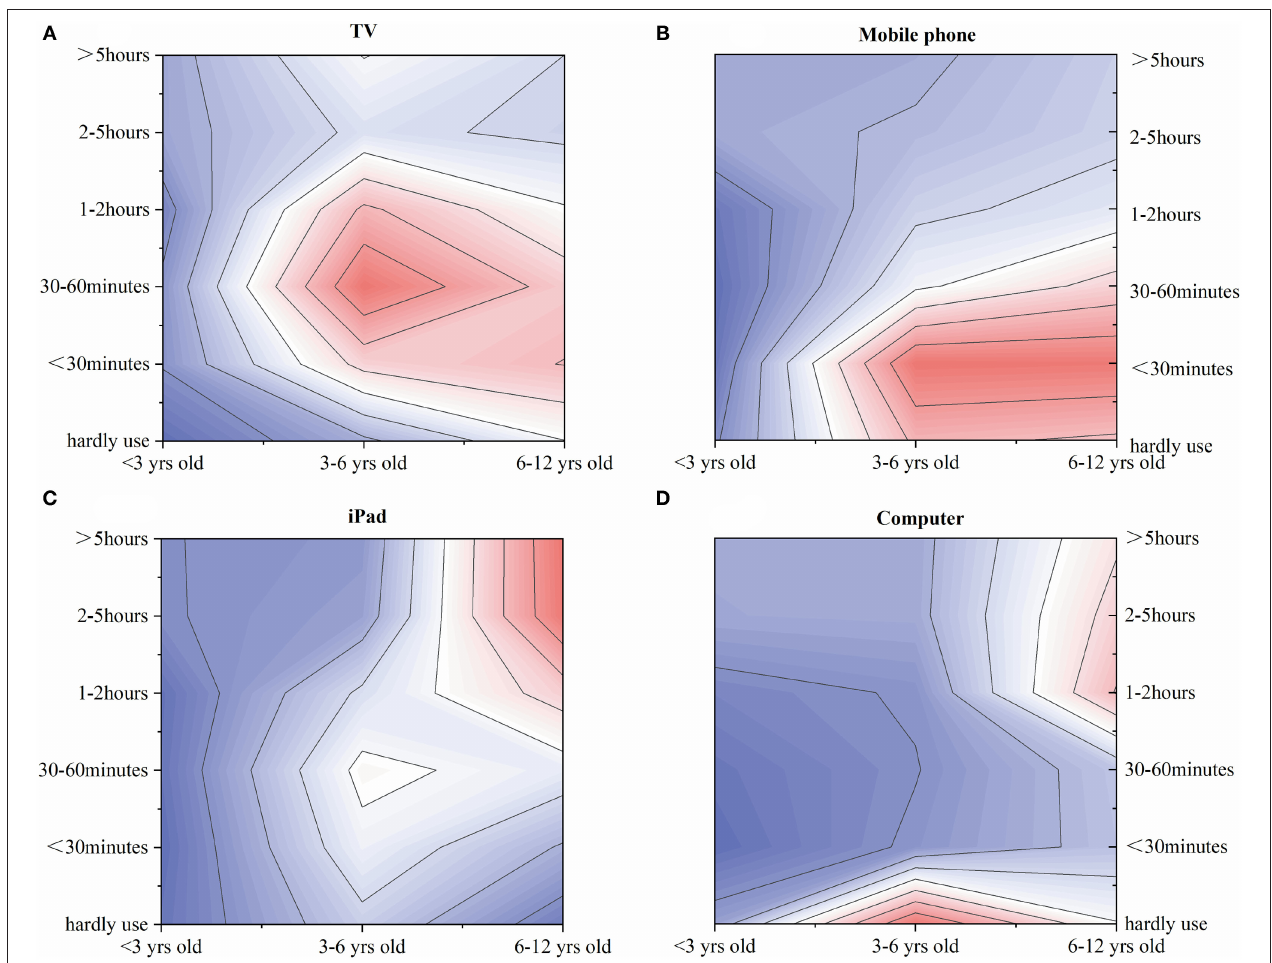
FIGURE 4 | Use of different electronic devices among children of different ages. The red color indicated a higher distribution intensity, while the blue color indicated a lower distribution intensity, and the white color represented the transition or the distribution intensity between the red and blue colors. The distribution intensity decreased with the color getting lighter. (A) Child TV-watching per day. (B) Child mobile-phone usage per day. (C) Child iPad usage per day. (D) Child computer-usage per